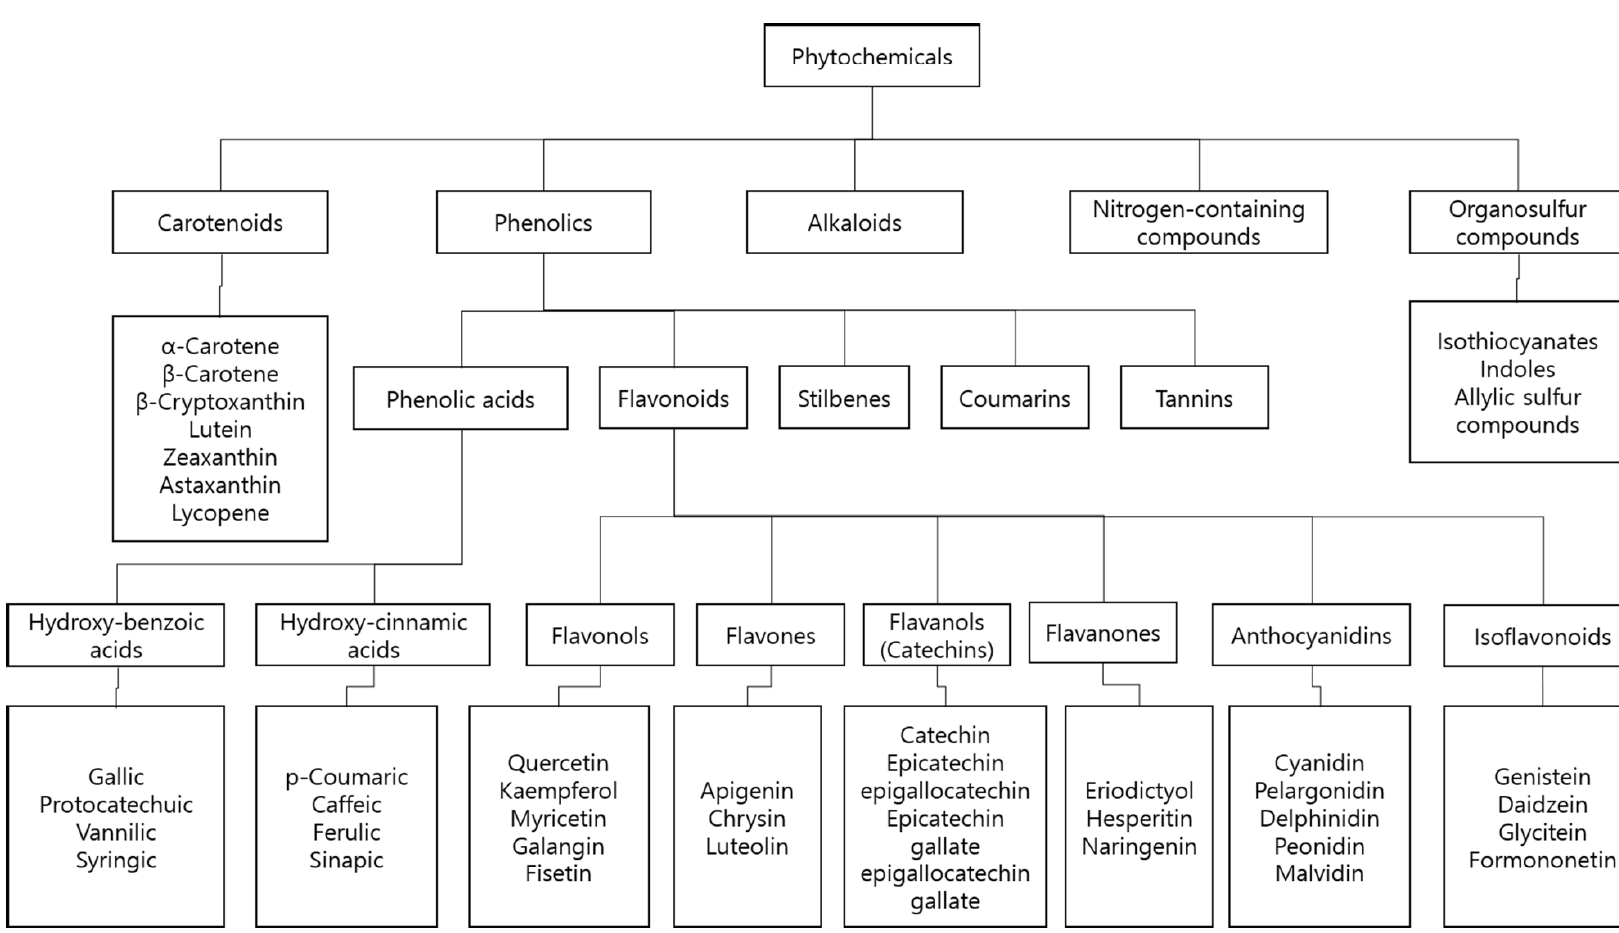
Figure 1. Classification of phytochemicals [7].